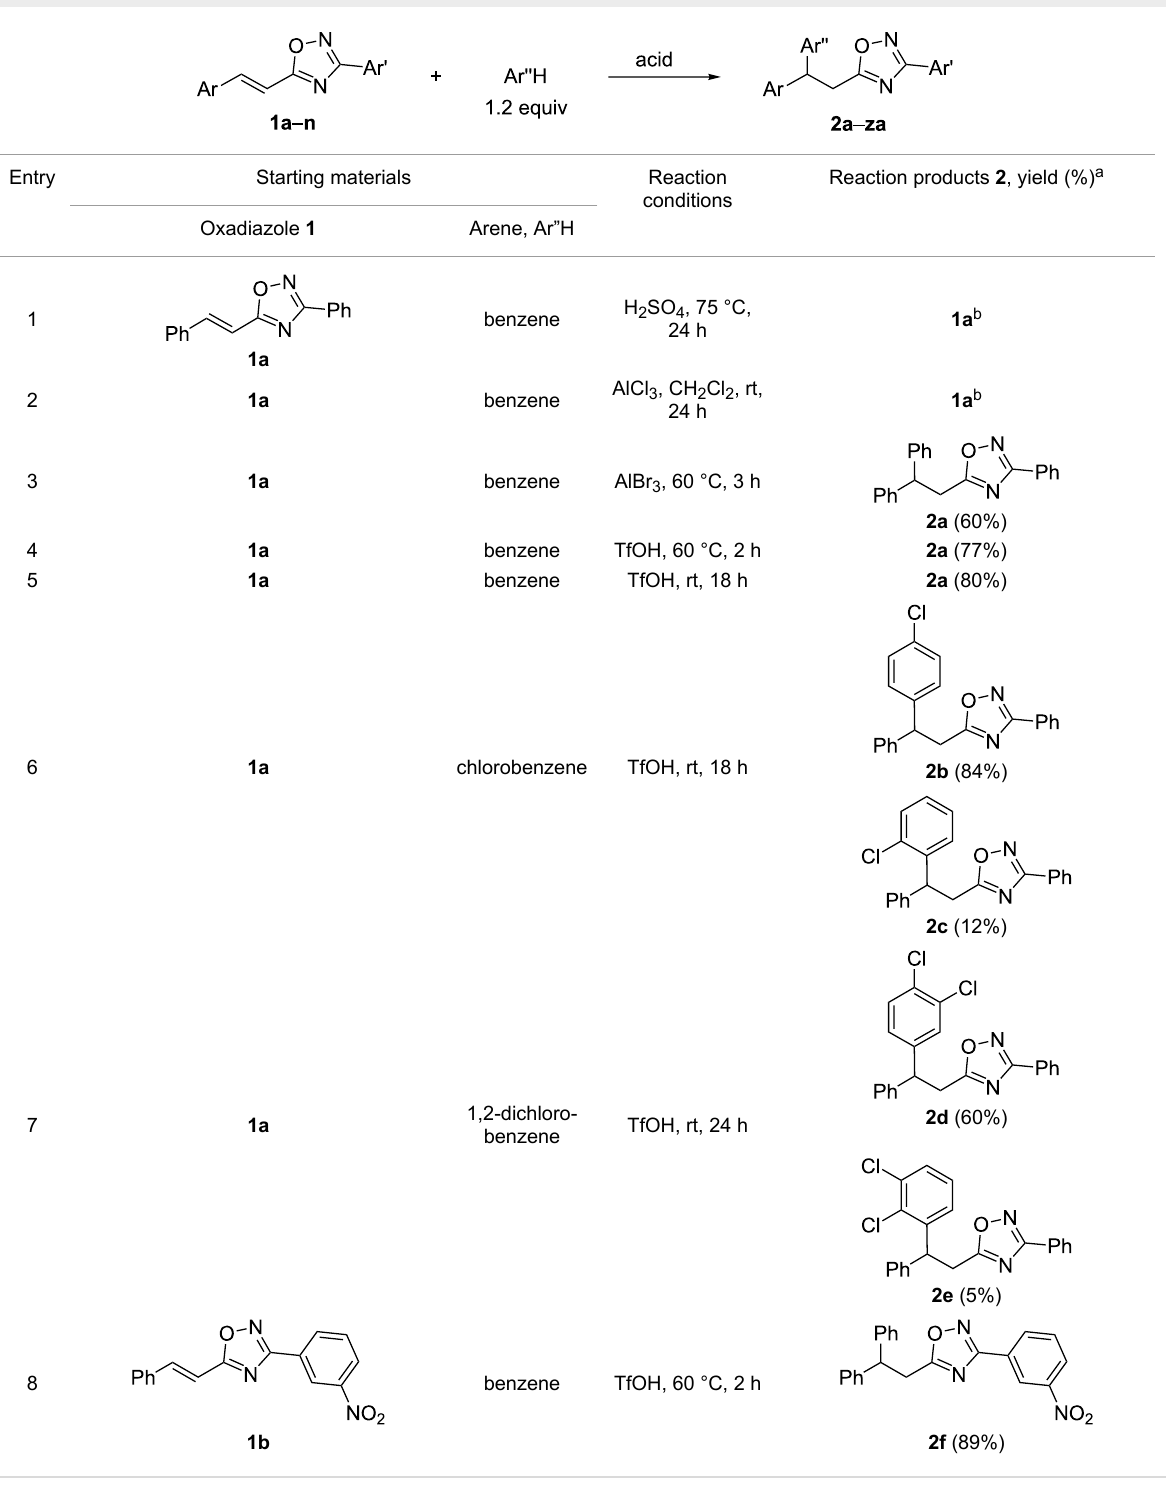
Table 2: Hydroarylation of oxadiazoles 1a–n with arenes under superelectrophilic activation leading to compounds 2a–za .